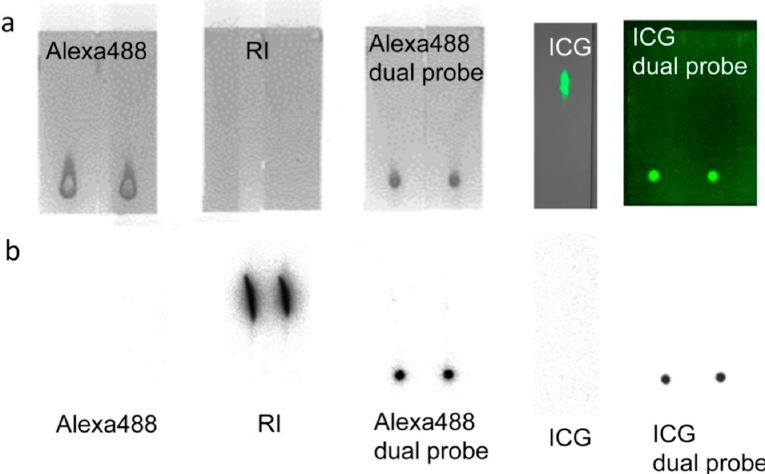
Figure 5. TLC analysis of dual-imaging probe. Two microliter spots of the modified PCSNs were visualized on TLC plates using fluorescence imaging ( a ) and contact radiography ( b ). Verification of complete modification was confirmed by a lack of separated spots in both studies. Combined labeling with both 99m Tc and Alexa 488, and both 99m Tc and ICG-sulfo-OSu for targeted PCSNs, were verified by TLC before each experiment. TLC was also carried out for standards (Free Alexa 488, 99m Tc, and ICG). They showed separation of fluorescent signals and radioactivity from spot areas ( a , b ).